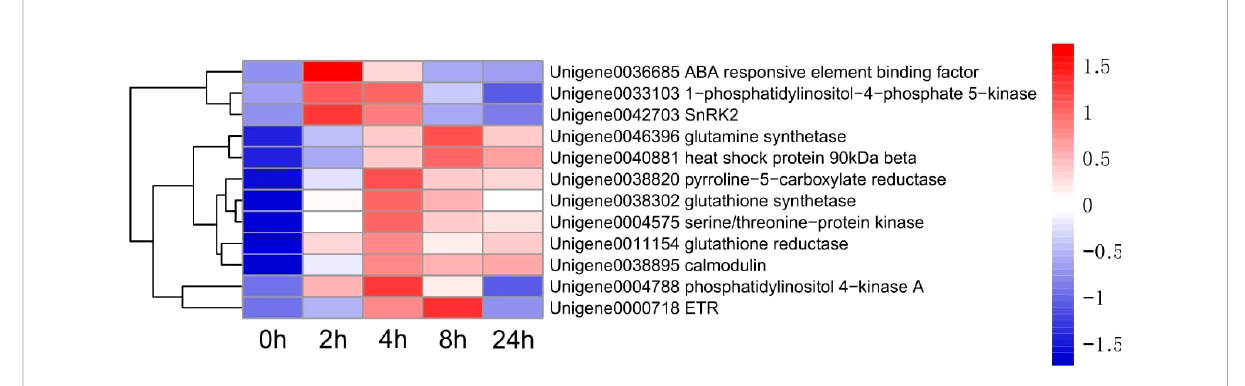
FIGURE 6 Heatmap of 12 genes expression.